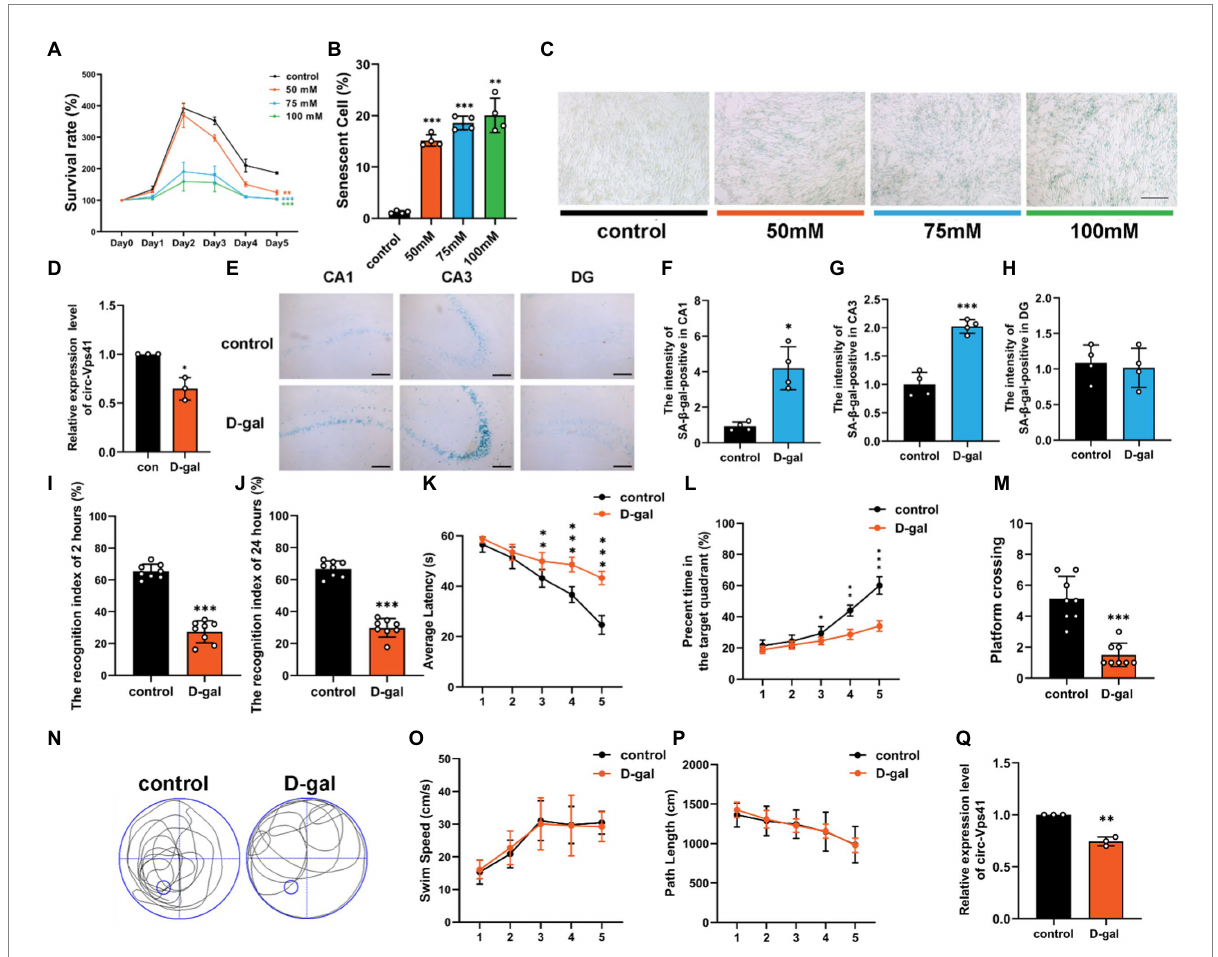
FIGURE 1 circ-Vps41 expression was downregulated in the D-galactose-induced aging model. (A) Cell growth assays (CCK8) demonstrate that treatment with D-galactose leads to decreased viability in HT22 cells, which (B,C) is confirmed by the high percentage of senescent cells in β -galactosidase staining (scale bars = 200 μ m). ANOVA was used to test for differences among all groups. (D) The expression level of circ-Vps41 was tested by qRT– PCR in HT22 cells in the control (con) and 75 mM D-galactose (D-gal) groups. The con group was normalized to 1. (E) SA- β -gal-positive cells could be observed in the hippocampus at CA1, CA3 and DG areas of D-galactose-induced aging mice. (Scale bars = 100 μ m). (F–H) Digitized for analysis by ImageJ software, stained levels of SA- β -gal-positive cells for D-gal group at CA1, CA3 and DG areas of the hippocampus in the ipsilateral side compared to the control groups ( n = 4 for control group, n = 4 for the D-gal group). (I,J) ORT test of mice at 2 and 24 h. (K) Time taken by mice to reach the platform (average latency) during the training trials. (L) Percentage of time in the target quadrants of mice during the training trials. (M,N) Numbers of platform crossings of mice and representative swimming paths in the 7-day MWM. (O,P) Average swim speed and total path length by mice to reach the platform during the training trials ( n = 8 for the control group, n = 8 for the D-gal group). (Q) The expression level of circ-Vps41 was tested by qRT–PCR in the hippocampus of mice in the control and D-gal groups ( n = 3 for the control group, n = 3 for the D-gal group). The control group was normalized to 1. Data are shown as the mean ± SEM. p values, two-tailed t -test, one-way ANOVA. * p < 0.05, ** p < 0.01, *** p <